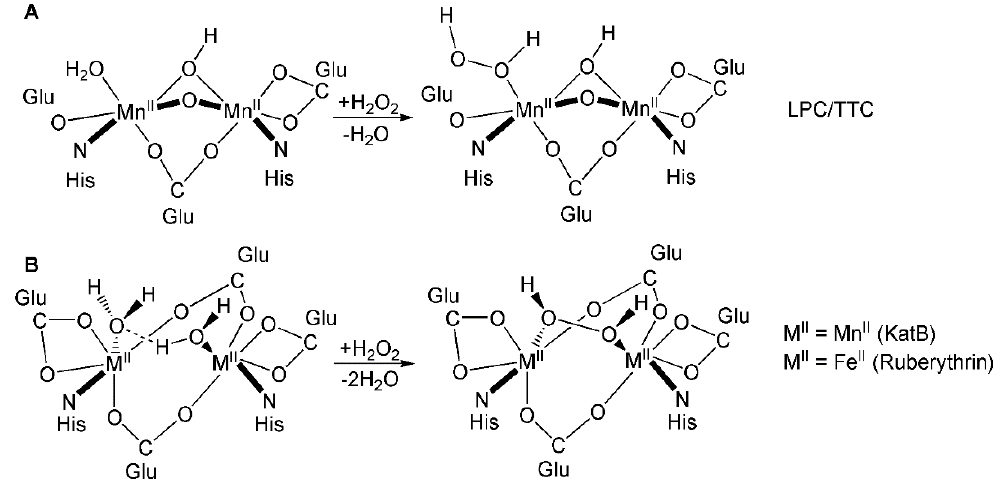
Scheme 1. Binding mode of H 2 O 2 in nonheme dimanganese and diiron